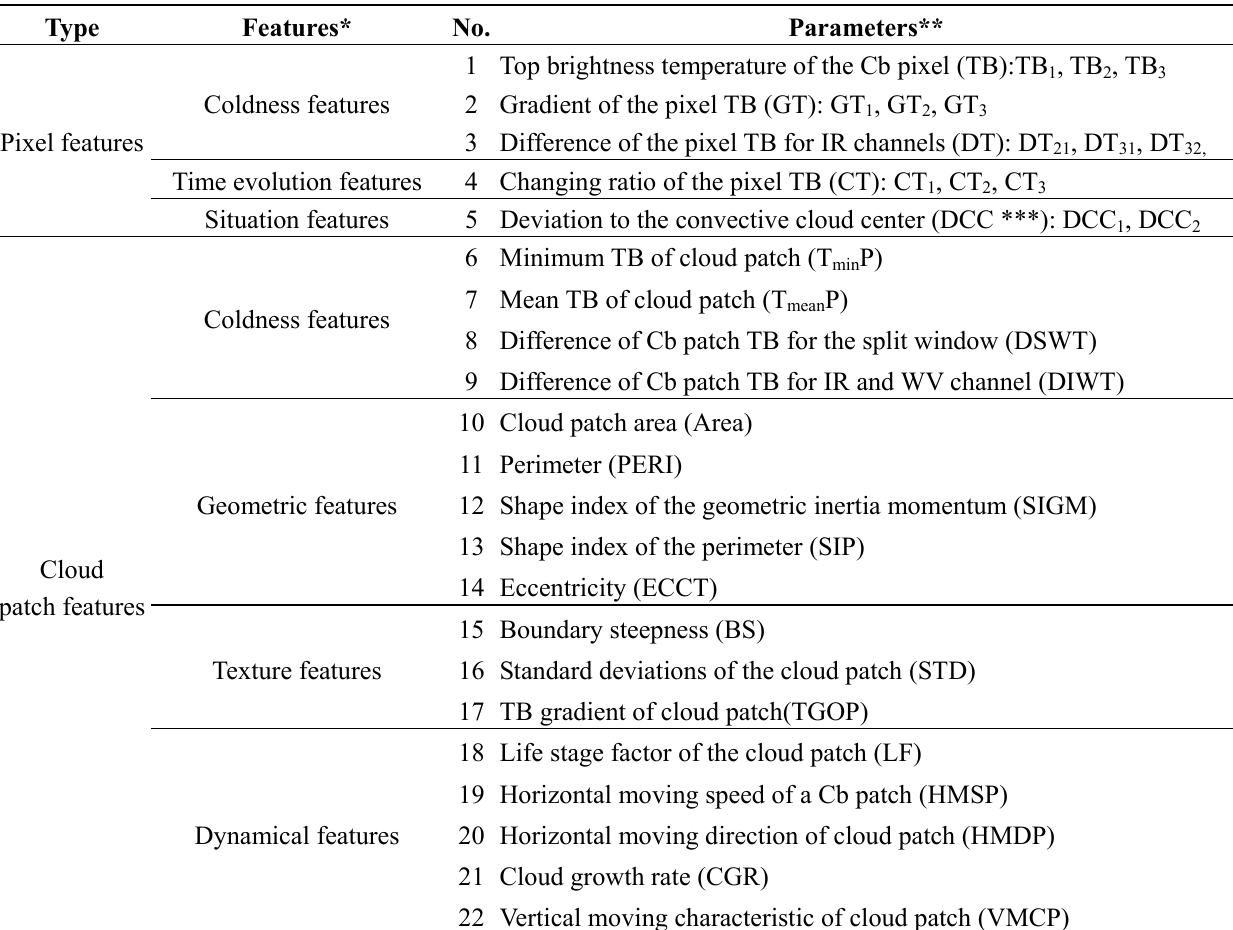
Table 1. Cloud characteristics derived from geostationary imageries. Cb, cumulonimbus; TB, top brightness; IR, infrared; WV, water